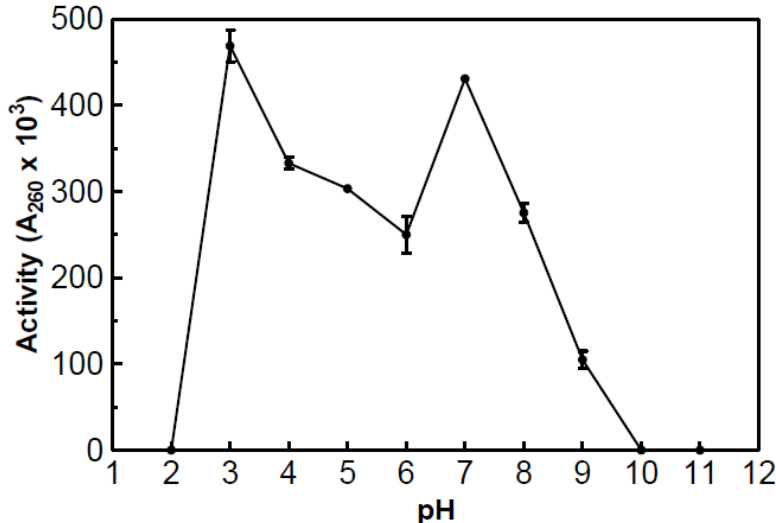
Figure 7. Plot of the partially purified RNase pH profile. The activity was measured using a modified version of the acid soluble assay at 55 °C with varying pH.